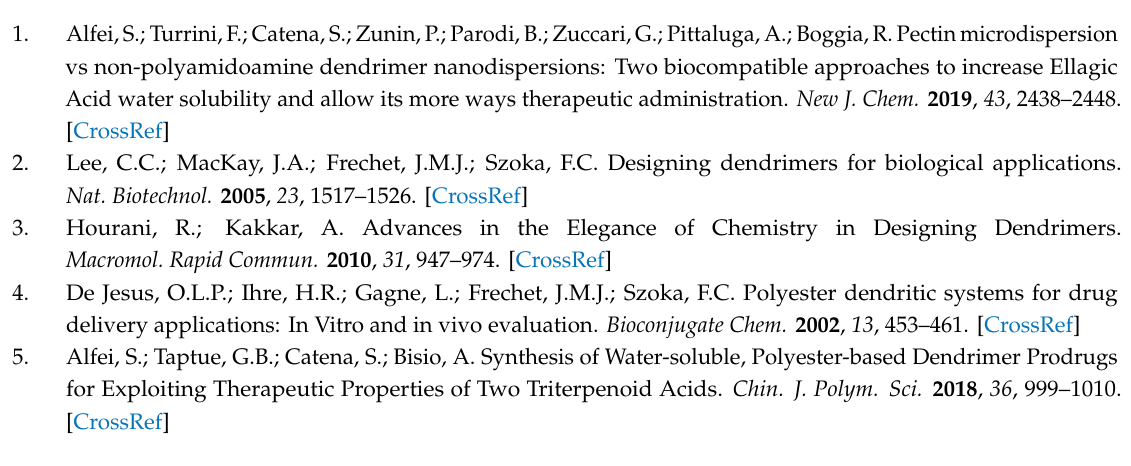
Figure S1: Structure of dendron intermediates achieved to synthetize 4 : D4BnA, D4BnOH, D5BnA, and D5ACOOH, Table S1: Molecular weight (MW) and significant physicochemical data of dendrimer 4 , Figure S2: Copies of FTIR (a), 1 H NMR spectrum (b) and 13 C NMR and DEPT 135 spectra (c) of dendrimer 4 , Figure S3: Copies of FTIR (a), 1 H NMR spectrum (b) and 13 C NMR spectrum (c) of ETO, Figure S4: Copies of FTIR (a) and NMR (b) spectra of CPX 5 , Figure S5: FTIR spectra of ETO (a), dendrimer 4 (b), and CPX 5 (c) with, in evidence, peaks of 4 (1), peaks of ETO (2), and peaks of 5 (3), Figure S6: 1 H NMR spectra of ETO (a), dendrimer 4 (b), and CPX 5 (c), Figure S7: Bi-plot and score plot of Components PC1 and PC2, Table S2: Data of the calibration curve: A average and ETO standards µ g / mL concentrations. ETO predicted concentrations, residuals, and ETO µ M concentrations, Figure S8: UV spectra of ETO dissolved in ACN / TDW 5 0:50 at the di ff erent concentrations used to build up the standard ETO calibration curve (a), standard ETO calibration curve (b), real ETO concentrations versus predicted ones (c), Absorbance (A) at λ = 286 nm versus standards ETO concentrations ( µ M) (d), Figure S9: Dynamic light scattering analysis of CPX 5